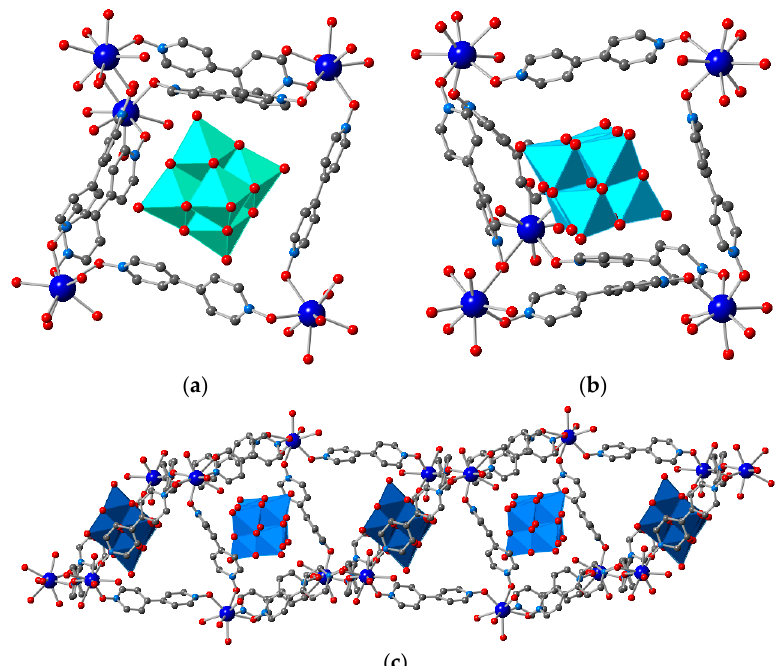
Figure 5. Different environments ( a , b , and c ) of the four crystallographically independent [W 6 O 19 ] 2 − anions after anion exchange (similar results are obtained for [Mo 6 O 19 ] 2 − ).